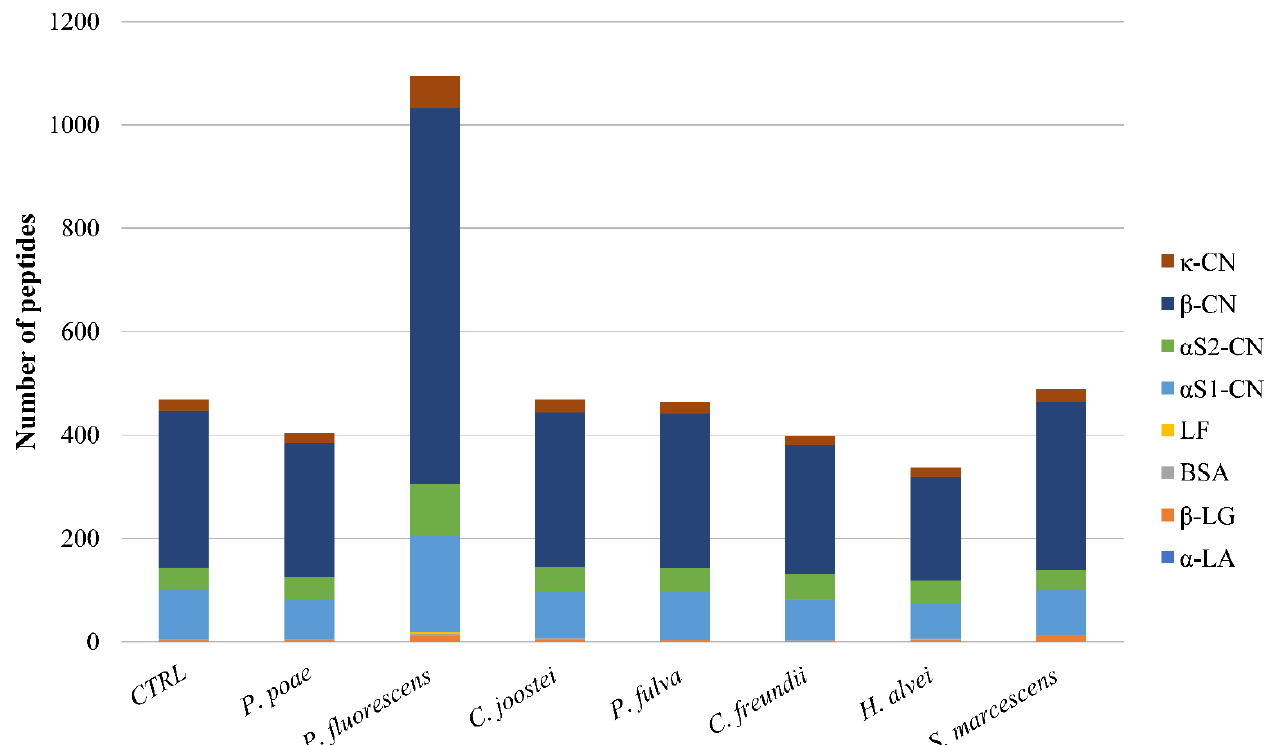
Figure 2. Number and precursor proteins of the peptides identified in CTRL pasteurized milk (CTRL), and in pasteurized milk samples inoculated with the psychrotrophic strains, after storage at 4 °C for five days. κ-CN, κ-casein; β-CN, β-casein; α S2 -CN, α S2 -casein; α S1 -CN, α S1 -casein; LF, lactotransferrin; BSA, bovine serum albumin; β-LG, β-lactoglobulin; α-LA, α-lactalbumin.